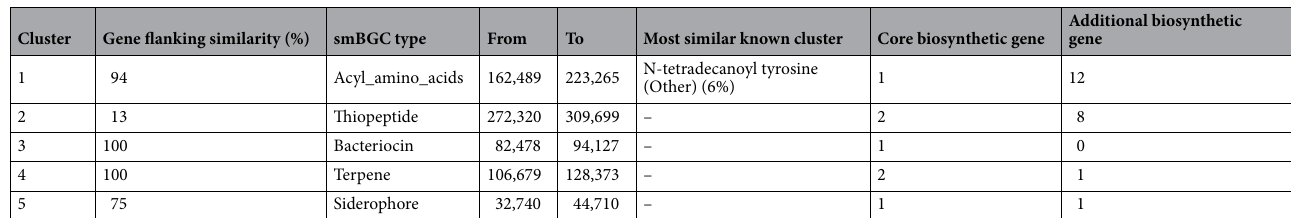
Table 2. Numbers of predicted secondary metabolite biosynthetic gene clusters (smBGC) of TW-1 T genome. The BGCs were determined using anti-SMASH